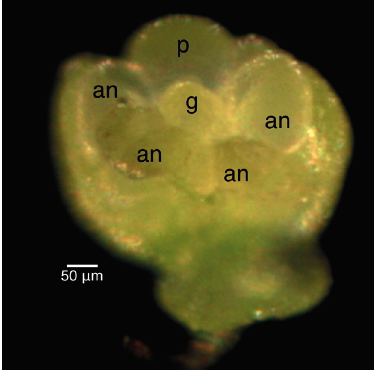
Figure 2. Stage 6 of 0.2-mm ( A ) and 0.25-mm ( B ) male infected floral bud with unilobal anthers and petals that were observed as small molds. “Mushroom”-shaped gynoecium can be observed here. Size bars, approximately 50 µm. g, gynoecium; st, stamen; p, petal.